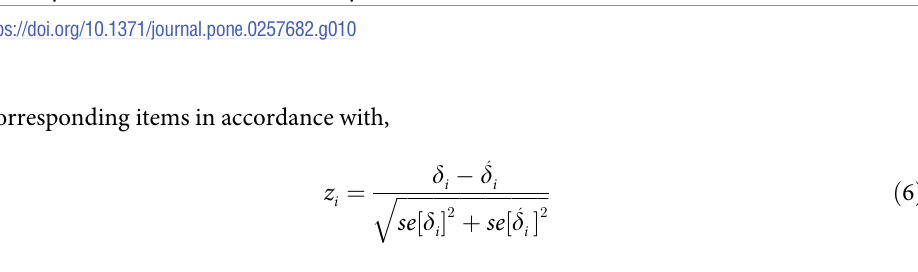
Fig 10. Dynamic tabular results for facet